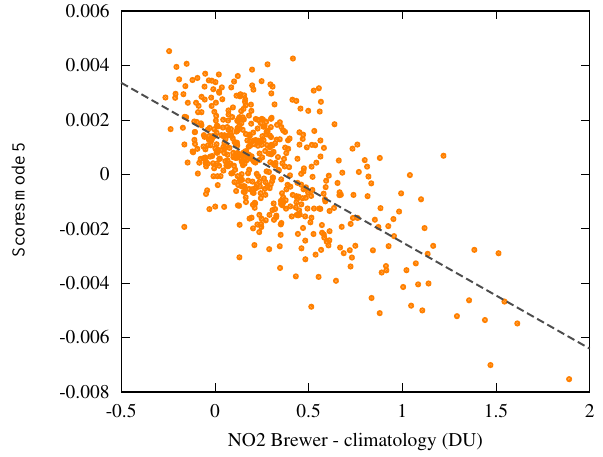
Figure 16. Scatterplot between the scores of the fifth component from the PCA and the difference between the measured and as- sumed nitrogen dioxide column, in Dobson units